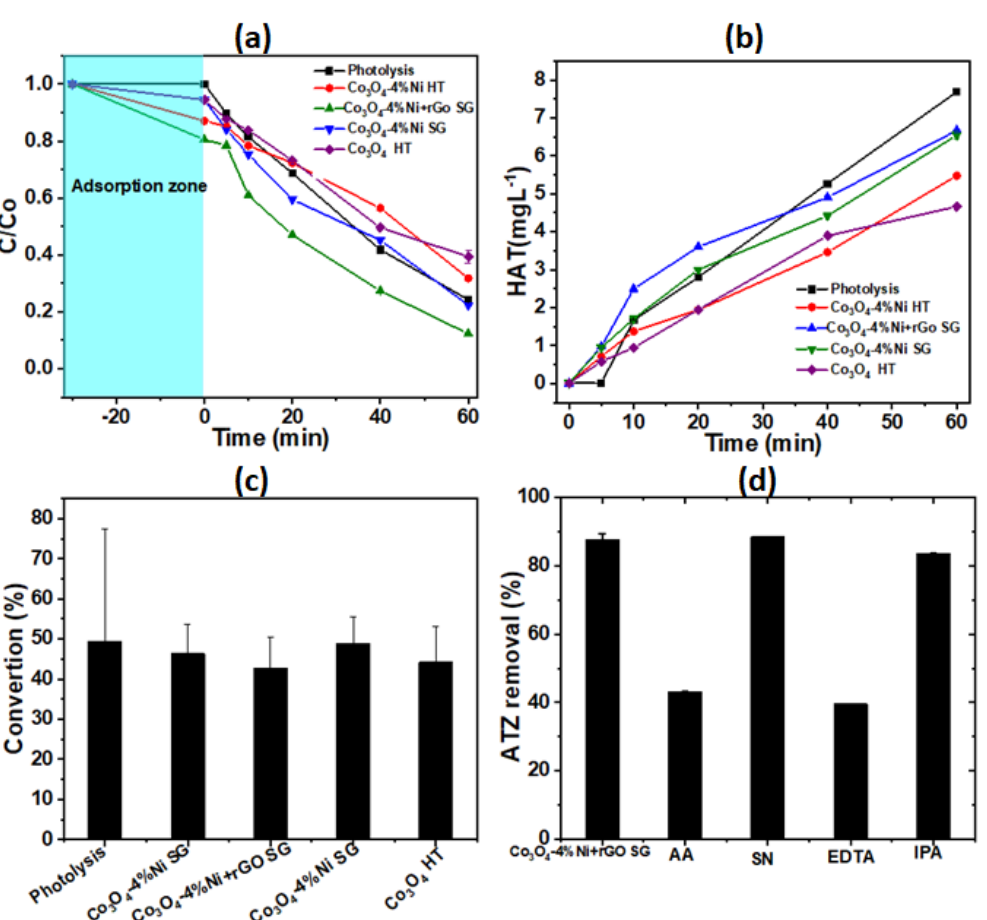
Figure 9. ( a ) Degradation rate: Co 3 O 4 -4%Ni HT, Co 3 O 4 -4%Ni+rGO SG, Co 3 O 4 -4%Ni SG, Co 3 O 4 HT; ( b ) concentration of HAT formed at each ATZ degradation time; ( c ) average conversion values of ATZ in HAT; ( d ) trapping experiments of the active species during the photocatalytic degradation of ATZ with Co 3 O 4 -4%Ni+rGO SG under UV radiation.